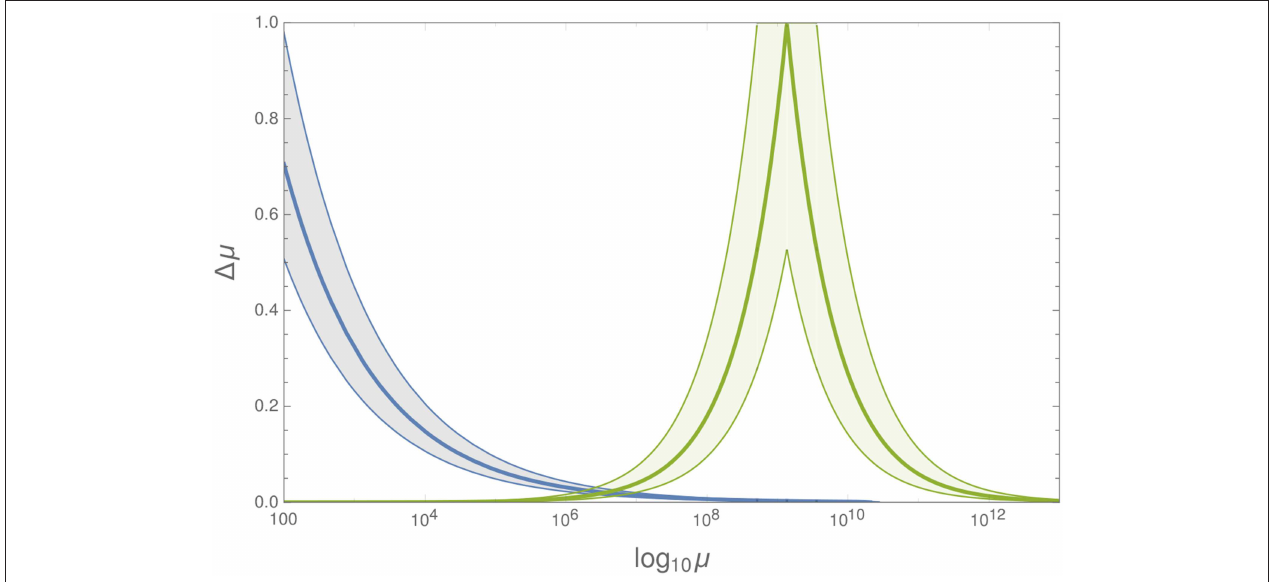
FIGURE 4 | Evolution of the unification measure with the SUSY scale for the MSSM with almost degenerate masses (blue) and scenario with lighter electroweakinos (green), calculated at one-loop. Shaded regions include threshold corrections over the solid lines.